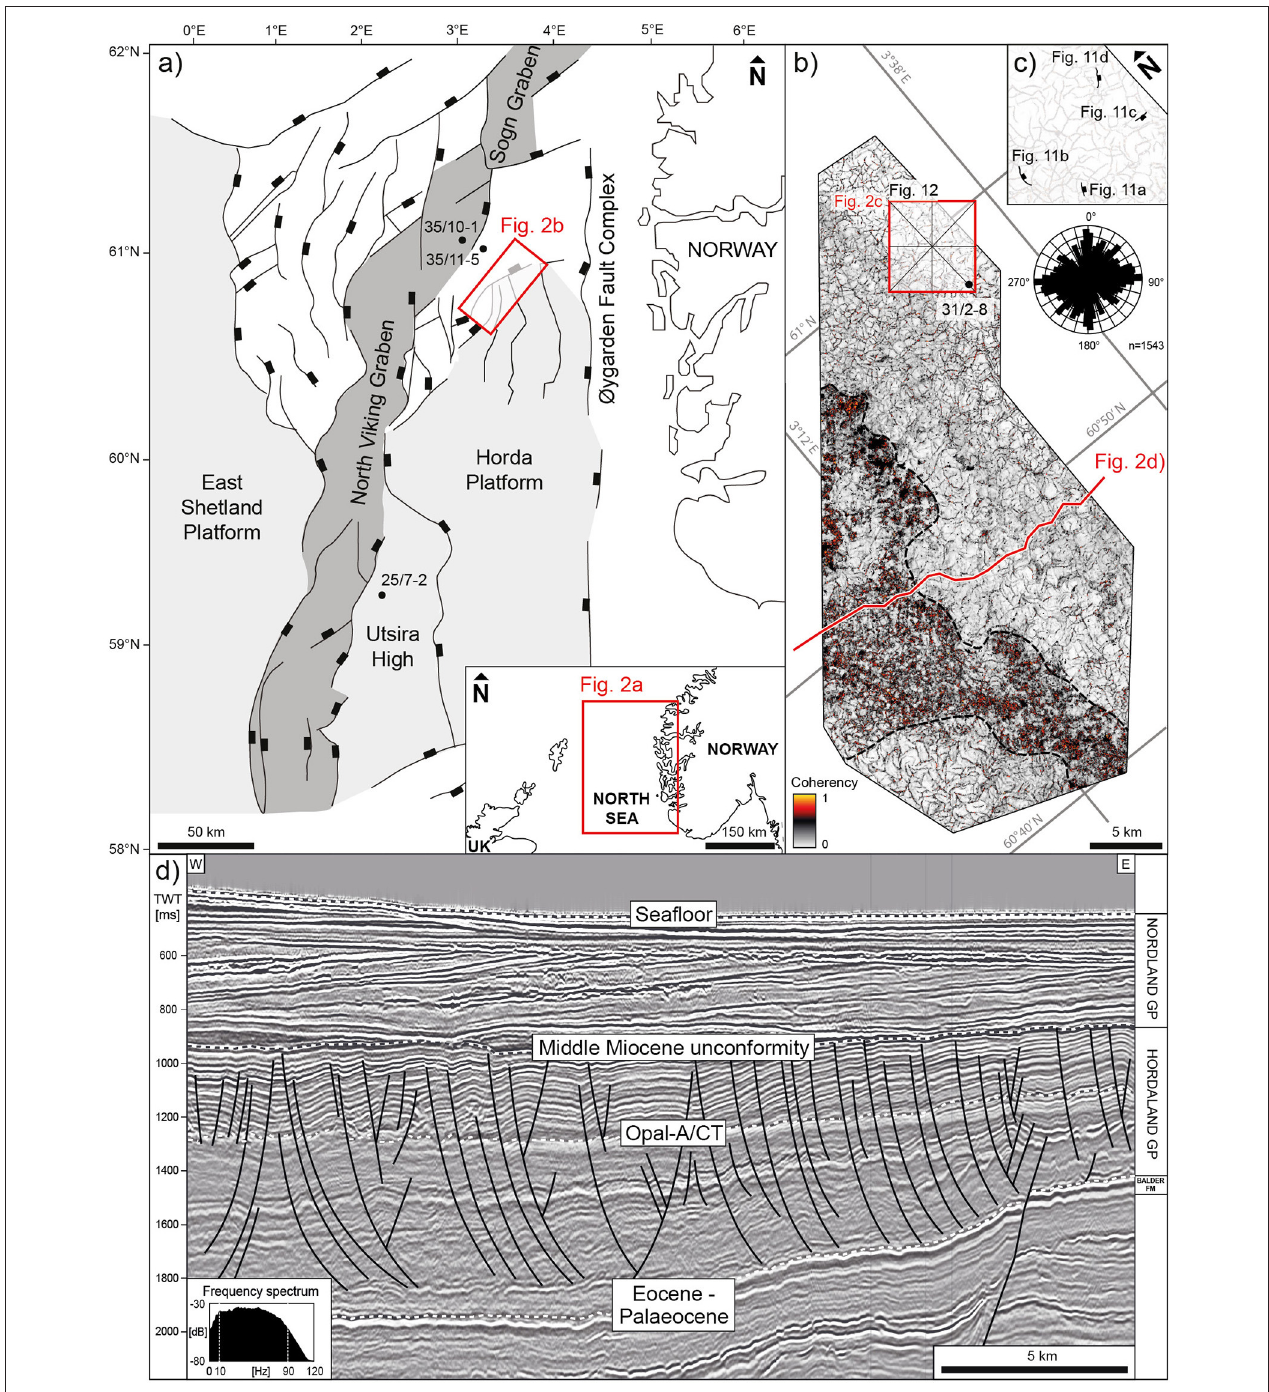
FIGURE 2 | (a) Simplified structural map of the North Viking Graben, North Sea, highlighting major faults; the Horda, East Shetland Platform and Utsira High (after Holgate et al., 2013) and the outline of the 3-D seismic survey (b) in red; (b) Outline of 3-D seismic survey (MN9201_R05) with coherency attribute map of seismic reflection of the opal-A/CT transformation in the Hordaland Group showing the characteristic polygonal fault pattern with more-or-less uniform distribution of fault strikes; the outline of the sub-cube (c) , the location of exploration well 31/2-8 and the position of the key seismic section (d) are also indicated; (c) coherency attribute map of sub-crop showing the position of polygonal faults used for detailed displacement extraction ( Figure 12 ); (d) Arbitrary, fault-perpendicular seismic section showing listric polygonal faults that are confined to the Hordaland Group in the North Viking Graben.